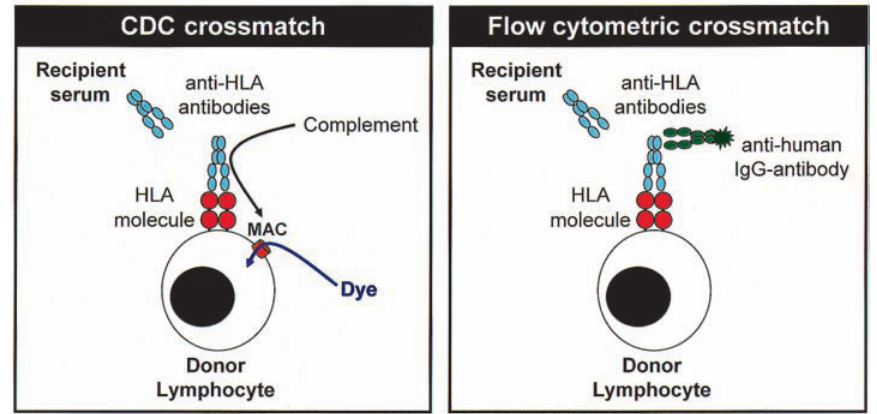
Cell-based methods for detecting HLA-DSA. The complement-dependent cytotoxicity crossmatch (CDC crossmatch) is performed by incubating T- and B-lymphocytes of the donor with serum from the recipient with subsequent addition of complement. If recipient antibodies bind to the donor cells, complement is activated, which creates “holes” in the cell membrane through the membrane- attack complex (MAC). A dye will then stain all cells with permeable membranes indicating anti- body binding. The result (percentage of stained cells) is determined by eye using fluorescence mi- croscopy. The flow cytometric crossmatch is performed by incubating T- and B-lymphocytes of the donor with serum from the recipient with subsequent addition of a fluorescent secondary antibody binding to human IgG-antibodies. The fluorescent intensity correlating with the amount of antibody binding to the cells is measured by a flow